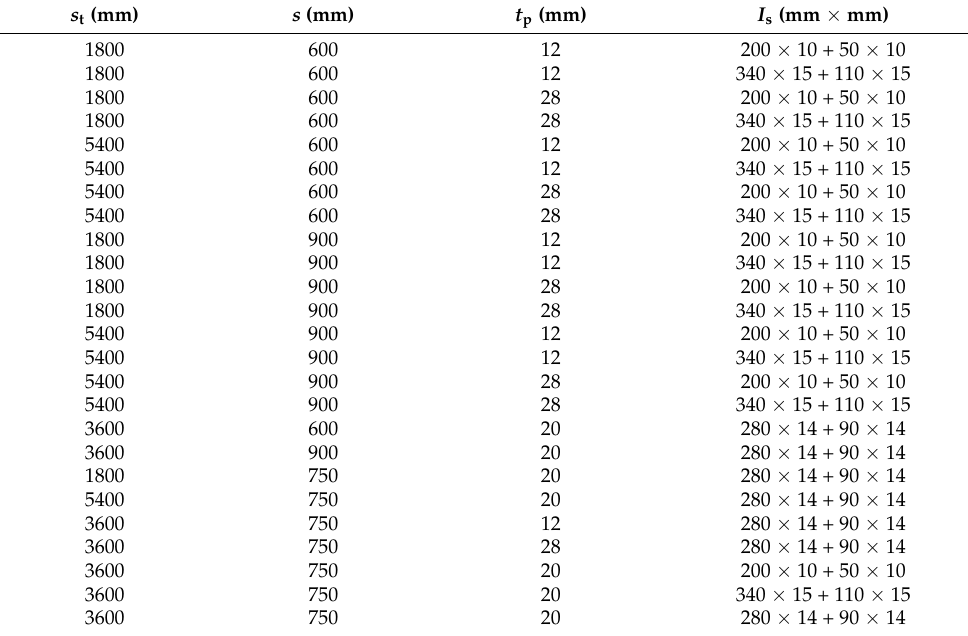
Table 4. The test matrix of the variables of the